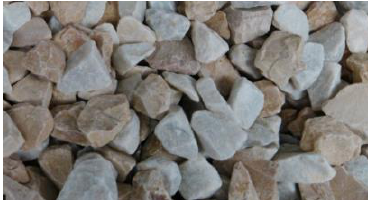
Figure 1. Surface view of the stones